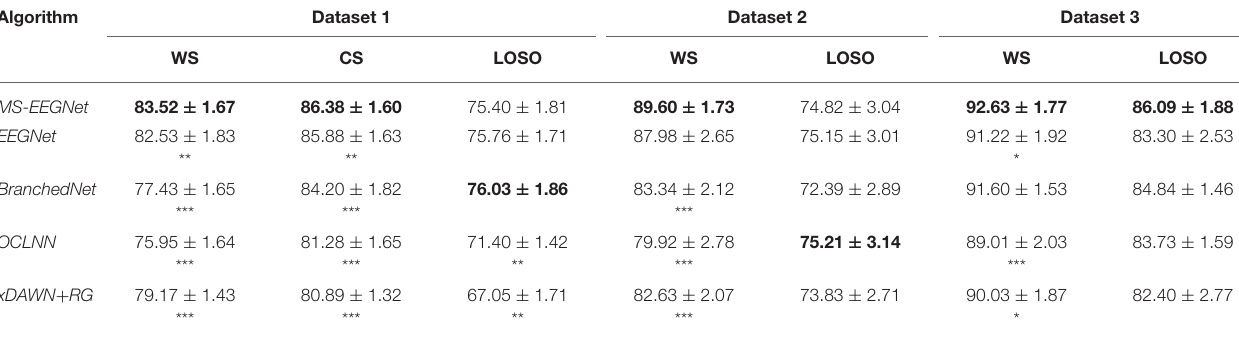
TABLE 3 | AUC (% mean ± SEM) obtained with MS-EEGNet and the re-implemented SOA algorithms adopting the WS, CS, and LOSO strategies.